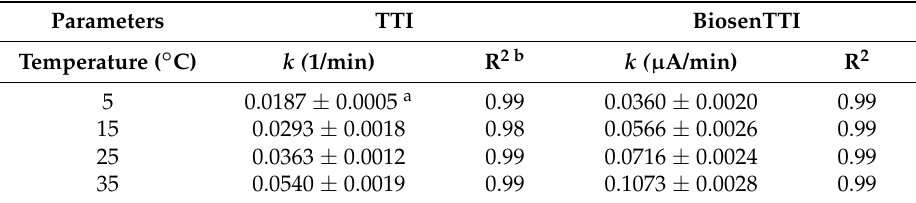
Figure 5. ( A ) Plot of color change at different isothermal temperatures ( ◆ : 5 °C, ● : 15 °C, ▲ : 25 °C, ■ : 35 °C) and ( B ) Arrhenius plot of the reaction rate constants (abs) against temperature. Table 1. Comparison of reaction kinetics between TTI and TTI biosensor.